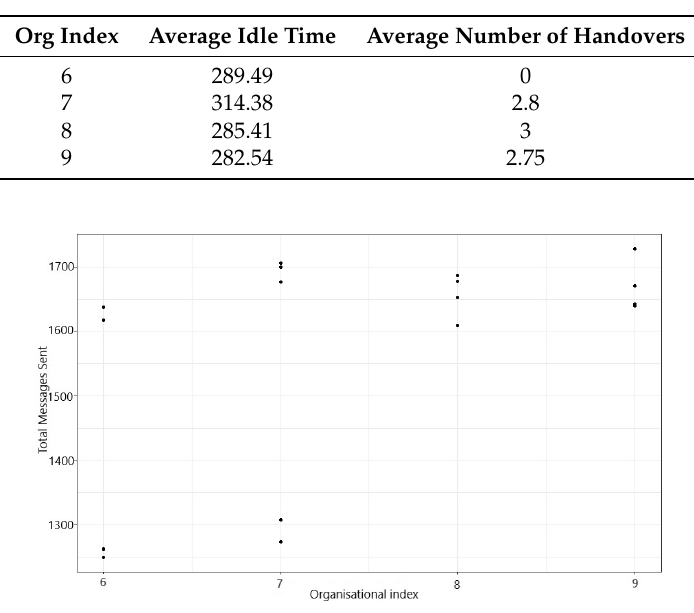
Figure 7. Total messages sent vs. Org index for 12-room